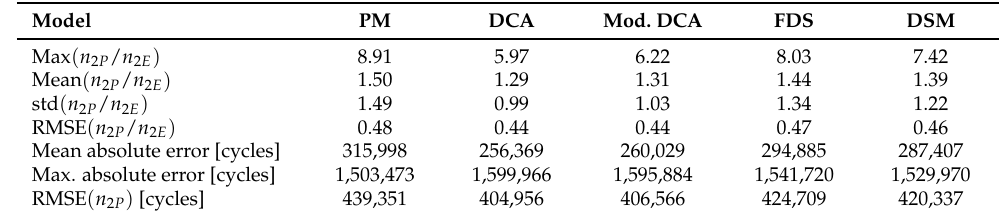
Table 4. Statistical analysis of the selected damage accumulation model estimations for two-level block loading sequences presented in Section